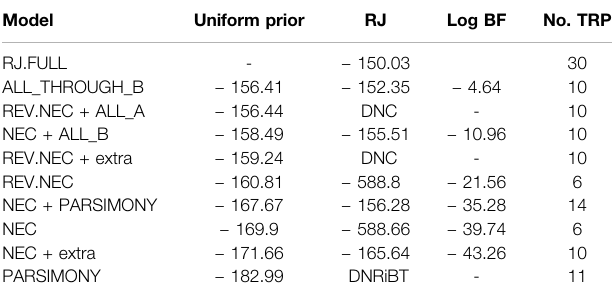
TABLE 3 | Performance of the manual models. Log BFs are calculated for each row using 2(log mLh RJ model − log mLh RJ.FULL). no. TRP (cid:1) no. of transition rate parameters included (but not necessarily turned on in RJ analysis).